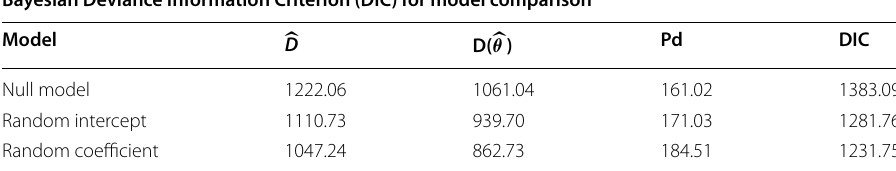
Table 4 DIC values for model comparison Bayesian Deviance Information Criterion (DIC) for model comparison